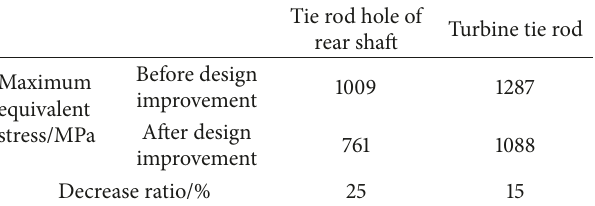
Table 4: The decrease ratio of maximum equivalent stress after design improvement.